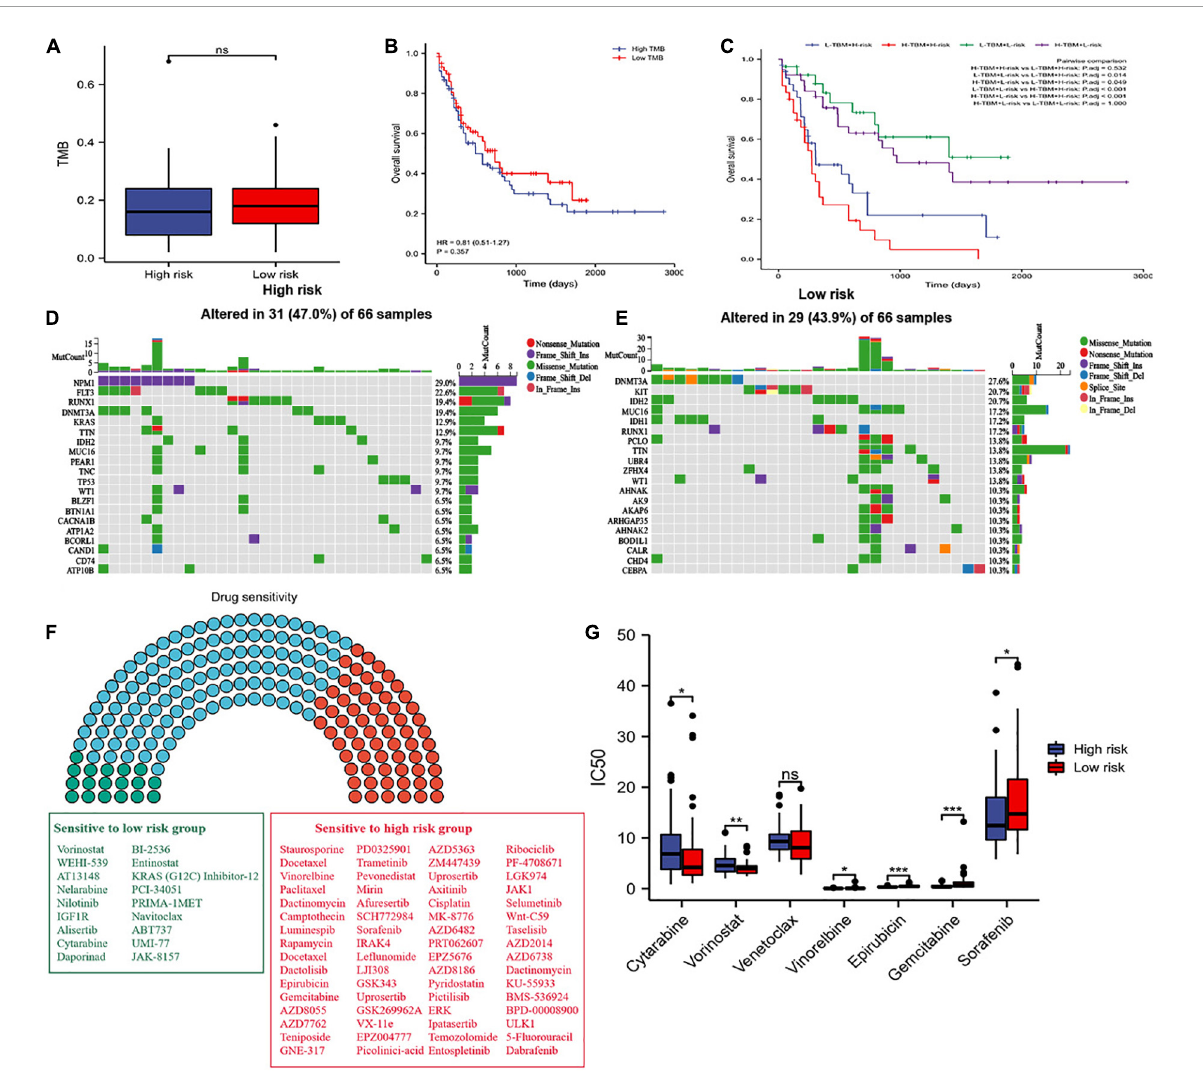
FIGURE9 Tumor mutation burden (TMB) and drug sensitivity analysis. (A) Difference in TBM between the two risk groups. (B) OS of patients with different TMB levels. (C) Kaplan–Meier analysis of OS with TMB and risk score. (D,E) Waterfall plot of the top twenty genes’ TMB status in the two risk groups. (F) Drug sensitivity analyses between the two risk groups. Green, sensitive drugs in low-risk group; Red, sensitive drugs high-risk group; Blue, no sense. (G) Comparison of drug sensitivity between the two risk groups. * p < 0.05, ** p < 0.01, *** p < 0.001, ns, no